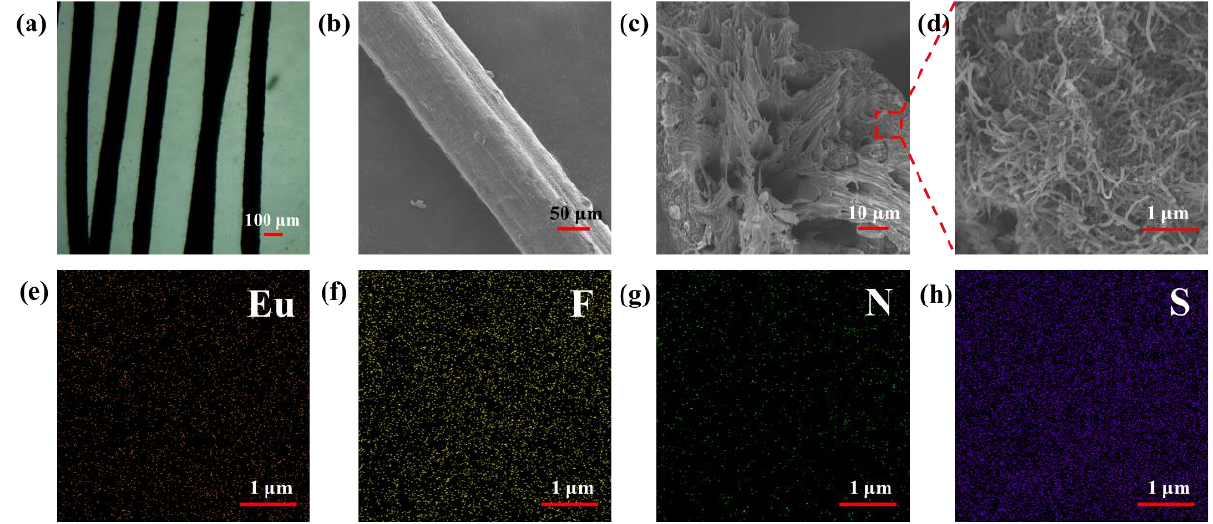
Figure 5. Micrograph ( a ) and SEM images ( b – d ) of E-uMWCNT-Fs; cross-sectional SEM elemental- mapping images ( e – h ) of E-uMWCNT-F (( e – h ) corresponding to Eu, F, N and S).